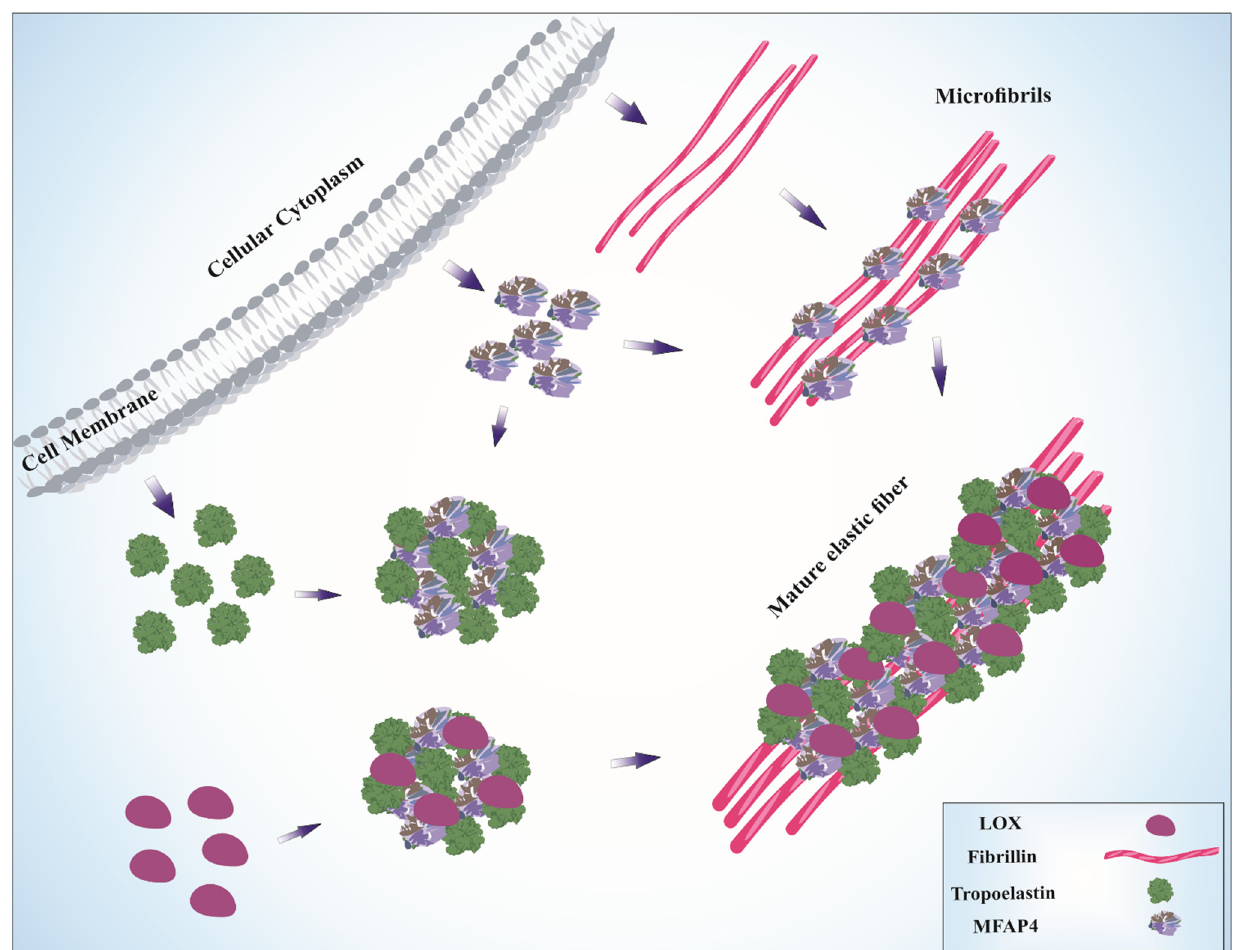
Figure 2. Contribution of MFAP4 to elastic fiber assembly. MFAP4, tropoelastin and fibrillins are secreted to the extracellular space. MFAP4 directly binds to fibrillins and participates in microfibril assembly. MFAP4 also promotes coacervation of single tropoelastin molecules. Tropoelastin then binds to the lysyl oxidase (LOX) and is cross-linked and deposited onto the microfibril scaffold to create a mature elastic fiber. MFAP4 also binds LOX independently from tropoelastin. For clarity, the MFAP4 octamers are presented in a simplified form.